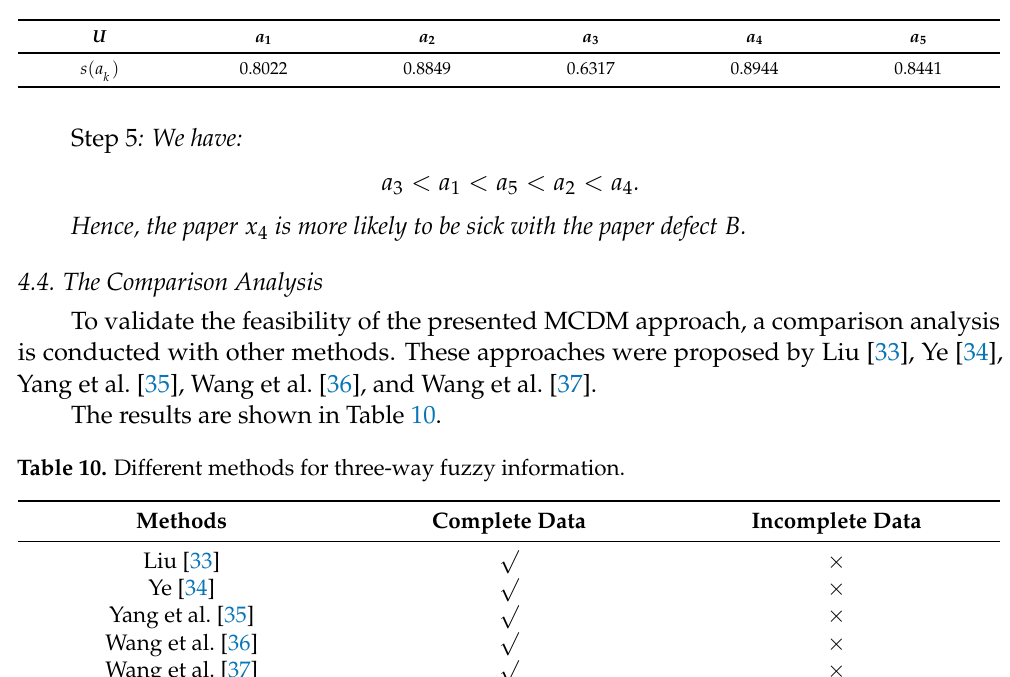
Table 11. The table in [37] which can be seen as a three-way fuzzy ( 0.5,0.1,0.8 )